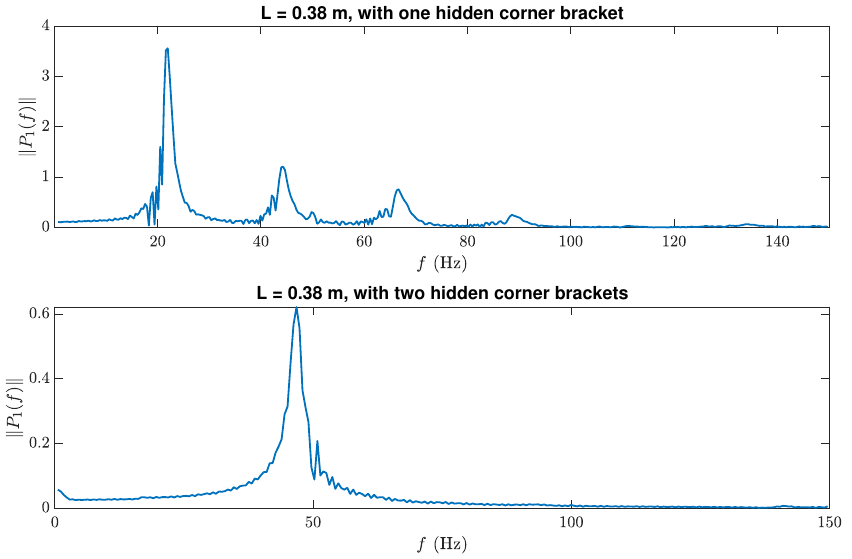
Figure 2. Experimental frequencies of the beam. ( Top ): one hidden bracket for fastening to a base is used, several peaks emerge because of the joint stiffness non-linearity [46]. ( Bottom ): two hidden brackets are used, the vibration is close to